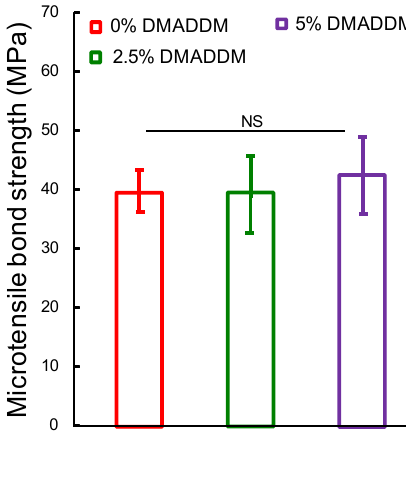
Figure 1. Microtensile strength of adhesive containing different mass fractions of DMADDM. Each values is mean ± SD ( n = 10) ( p >